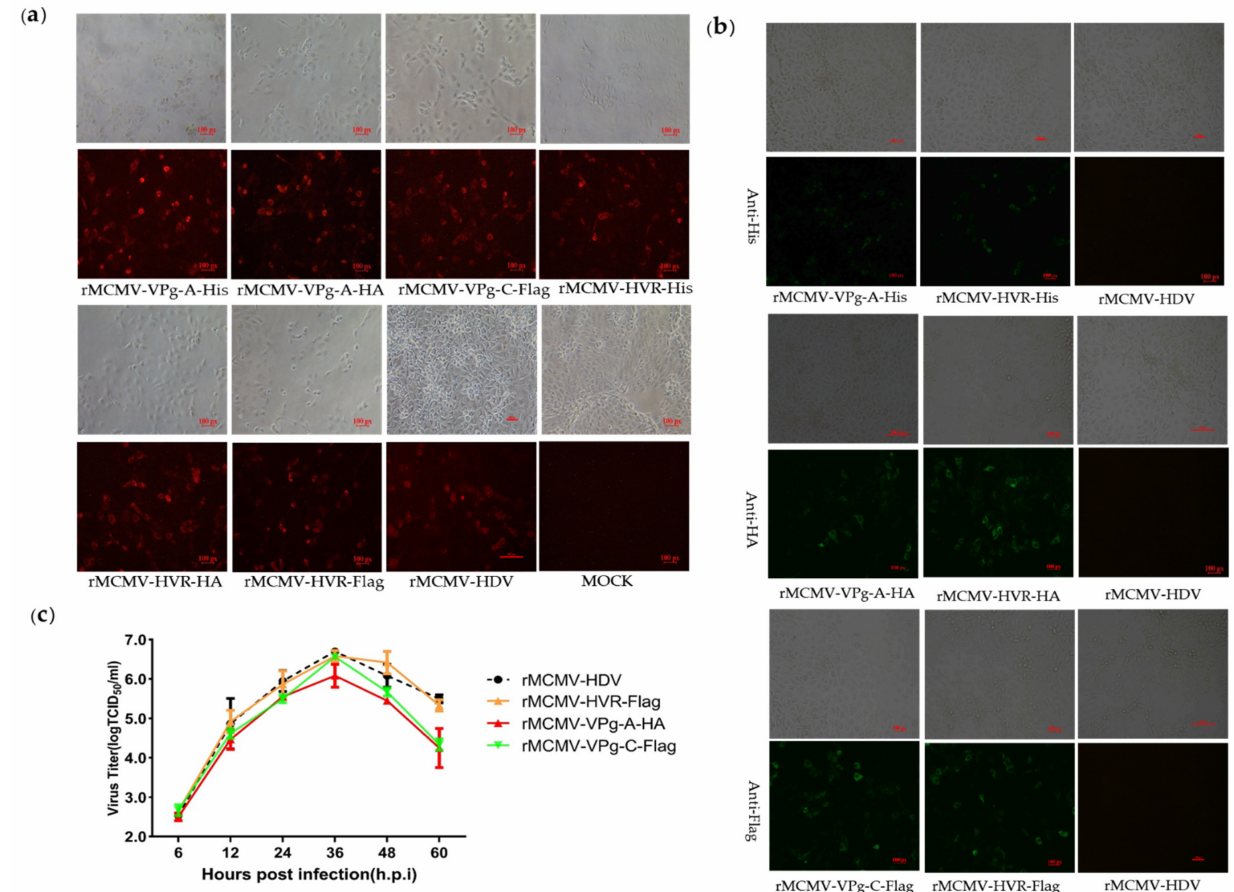
Figure 3. Recovery and characteristics of recombinant viruses harboring epitope tags. ( a ) IFA analysis of the Cap expression in PK-15 cells. Recombinant virus-infected PK-15 cells were incubated with a mouse PcAb against capsid protein and stained with goat anti-mouse IgG H&L (CoraLite594). ( b ) IFA analysis of the tags expression in PK-15 cells. The PK-15 cells were infected with recombinant virus harboring epitope tags and incubated with mouse mAbs against the His, Flag, or HA-tag. The PK-15 cell was stained with goat anti-mouse IgG H&L (CoraLite488) (magnification 20 × ). ( c ) Growth curves of the recombinant and parental viruses. PK-15 cells were infected with recombinant virus harboring epitope tags at a multiplicity of infection of 0.01. Cell supernatants were collected at 6, 12, 24, 36, 48, and 60 h.p.i and the virus titers were determined by their TCID 50 in PK-15